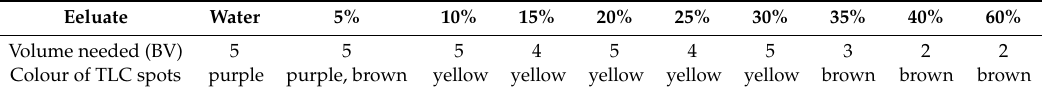
Table 2. The volumes of eluents needed in the gradient elution and TLC results of eluates. Eeluate